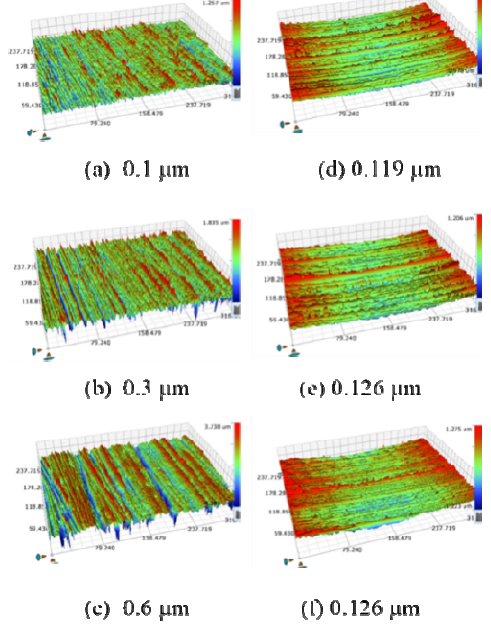
Figure 3. Optical micrographs of block surface roughness before ( a, b, c ) and after ( d, e, f )